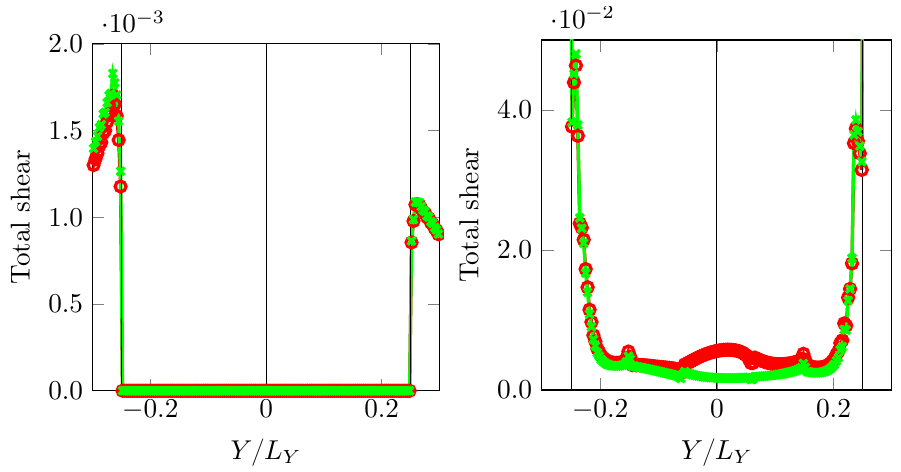
( b ) Distribution of total shear. Red and green curves represent resulting profiles for hard and soft martensite variants between O 1 O 2 , respectively. Figure 11. σ 11 and total shear distribution along path X = T prior austenite and ) at two different overall deformation levels, ¯ F 11 = 1.00125 ( left column) and A 1 A 2 ¯ F 11 = 1.00875 ( right